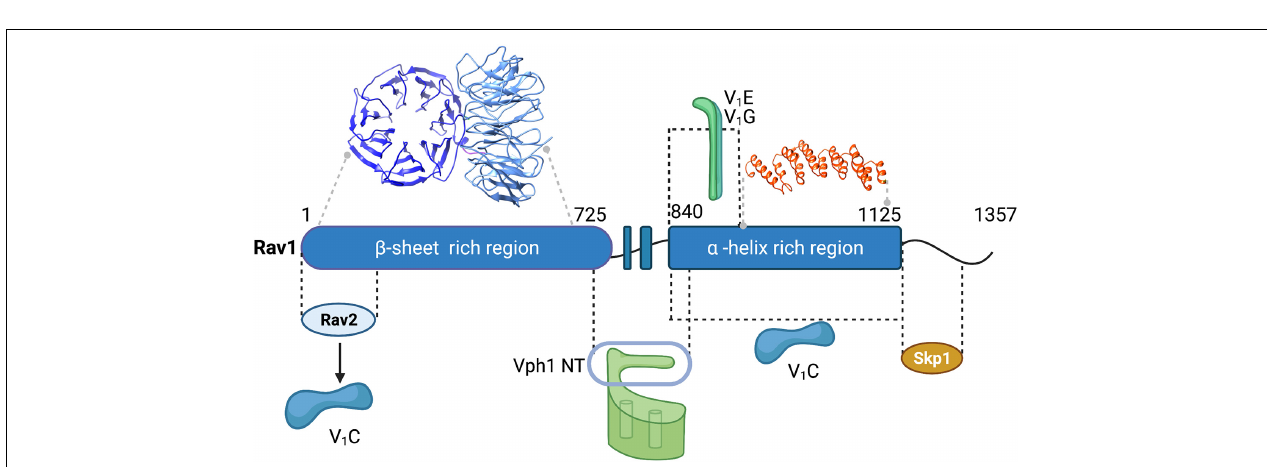
FIGURE 2 | Reversible disassembly of the yeast V-ATPase. Active, assembled V-ATPases (left) couple hydrolysis of ATP to H + transport across membranes. In yeast, glucose deprivation triggers disassembly and inactivation of some of the V-ATPase complexes. The V 1 complex and subunit C are separately released from the membrane-bound V o subcomplex into the cytosol, and both ATP hydrolysis and H + -transport are inhibited (right) . Upon glucose readdition, the RAVE complex helps to catalyze V-ATPase reassembly and reactivation.